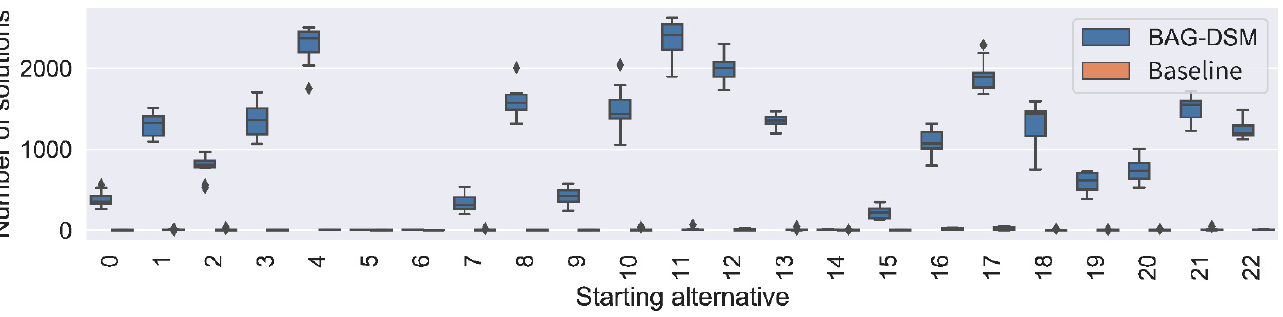
Figure 10. Boxplots for the time (shorter is better) required to find the first optimal alternative by BAG-DSM vs. baseline for the Landmark model. 5.2.2. Benchmark Models The same experiments presented in the previous subsection were repeated for the 42 benchmark models, and the same metrics were used to analyze the results. Thus, the next three figures present the distances, time to the first solution, and the number of solutions. Different from the previous graphs, the results are presented via paired boxplots. All our experiments are paired experiments, i.e., for given experimental conditions (e.g., a decision model, a starting alternative, and a desired outcome), a pair of experiments was performed, one set of experiments with the proposed method and another set of experiments with the baseline. We use the term “set of experiments” because each experiment was repeated 10 times to minimize the influence of the randomized steps on the experimental results. The lines connect the experimental runs that had the same experimental conditions (same model and same starting alternative). The blue line shows that our method was better for those specific experimental conditions. The red line shows that the baseline was better for those specific experimental conditions. The corresponding set of alternatives is compared using: the number of attribute changes required to reach the generated alternatives (Figure 11); the time to obtain the first appropriate alternative, Figure 12; and the number of generated alternatives (Figure 13). Figure 11 presents the distance between the final solution and the starting alternative. From the results, it can be seen that in all of these experiments, BAG-DSM found solutions with equal or shorter distances compared to the solutions found by the baseline. The dif- ference is larger for the more complex models (depth 4 and depth 5).